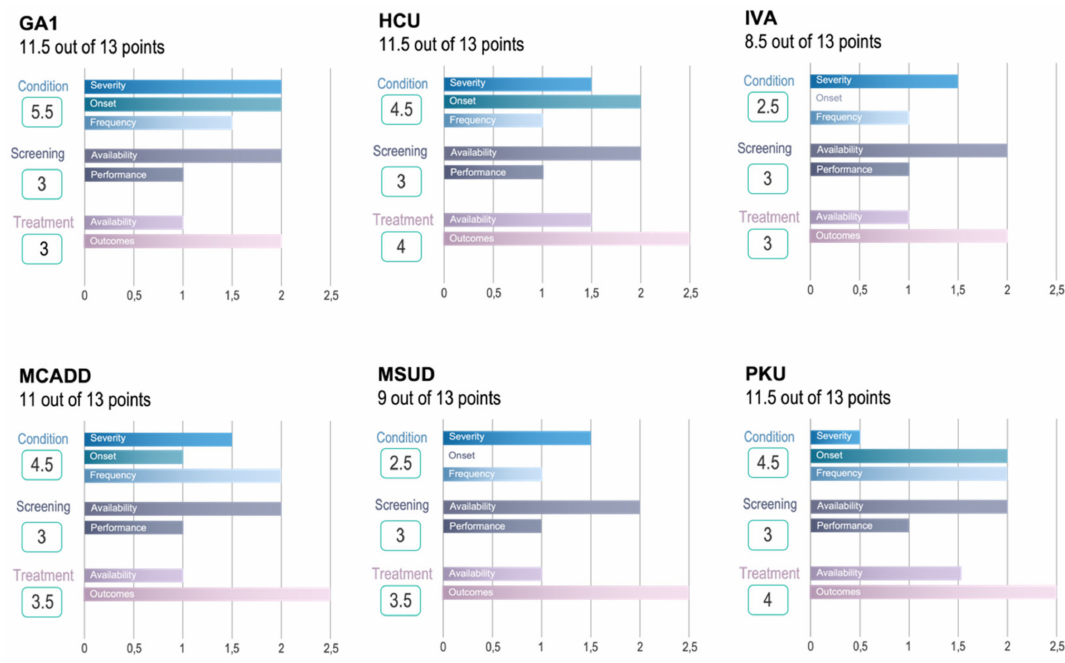
Figure 3. Total scores for the six IMDs on the UK newborn screening